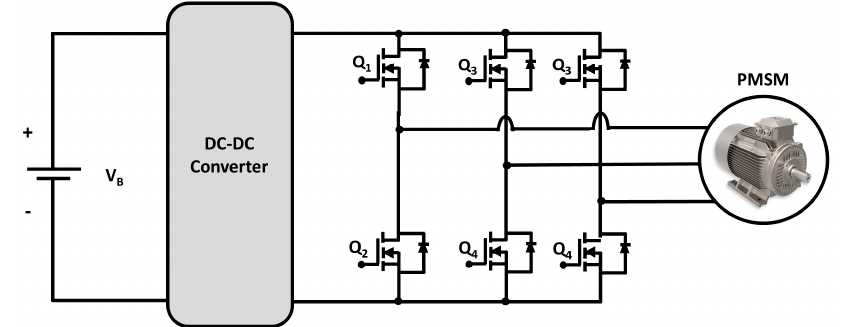
Figure 29. Topology of a two-level inverter (TLI).